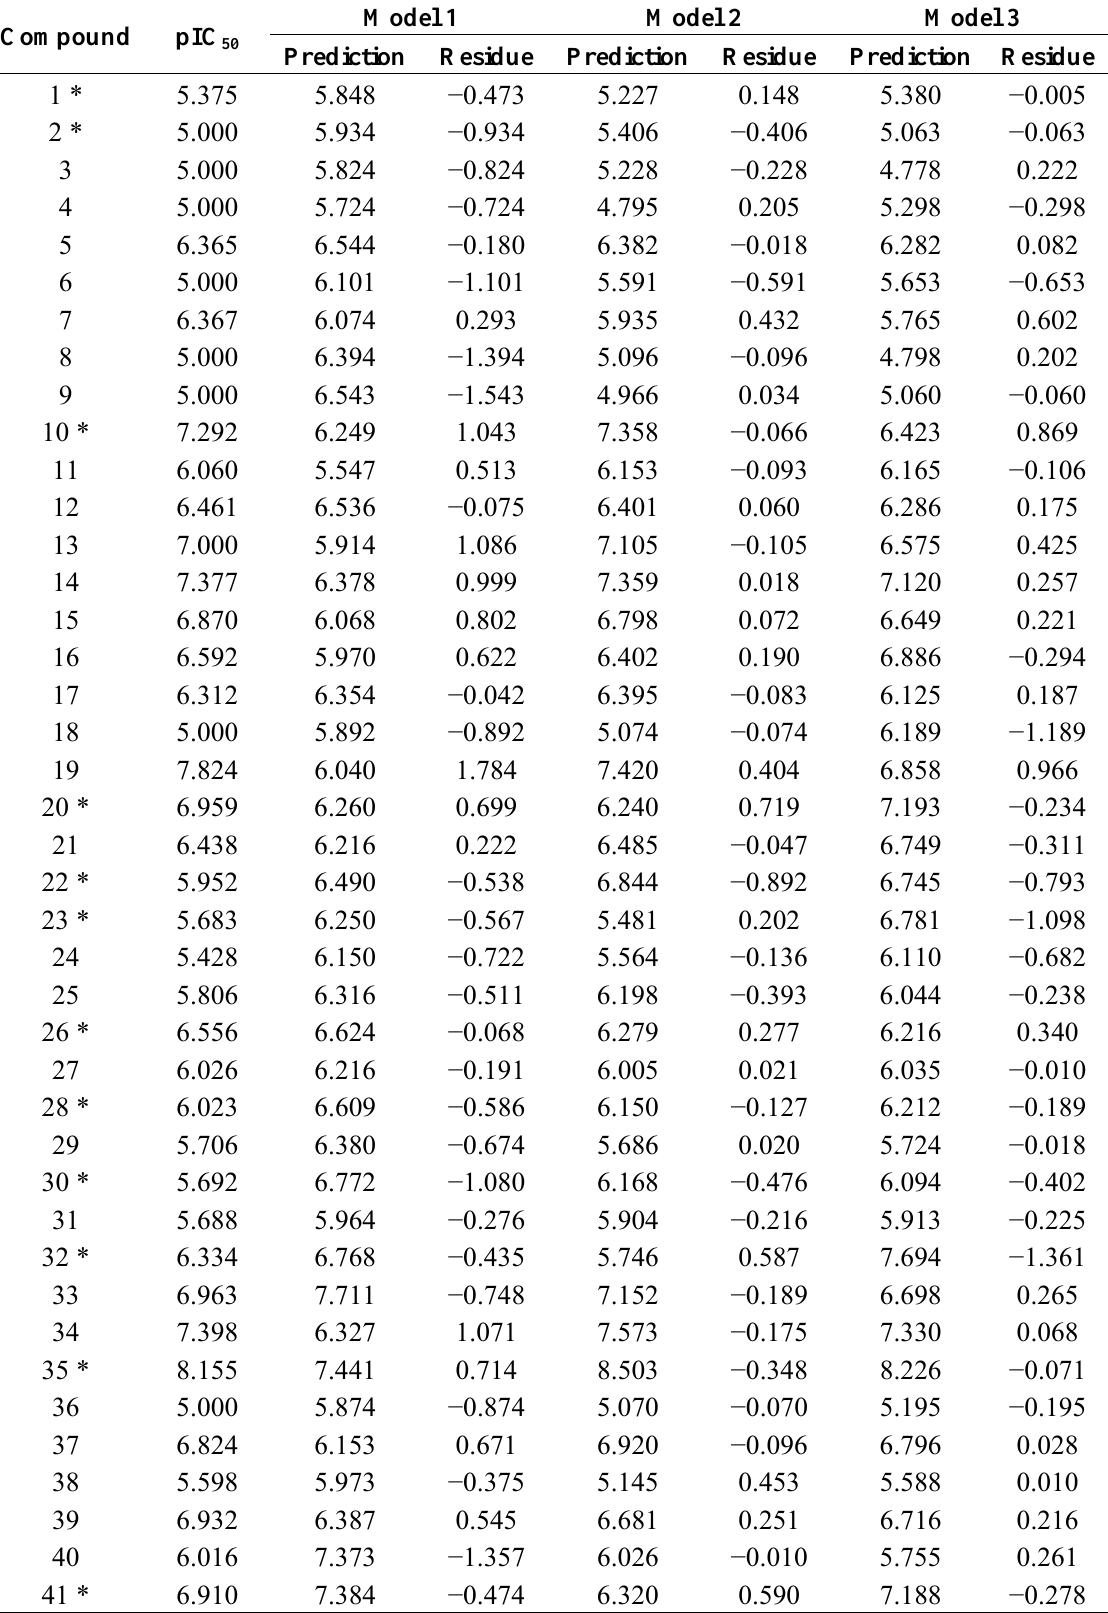
Table 3. The experimental pIC derived from the CoMFA